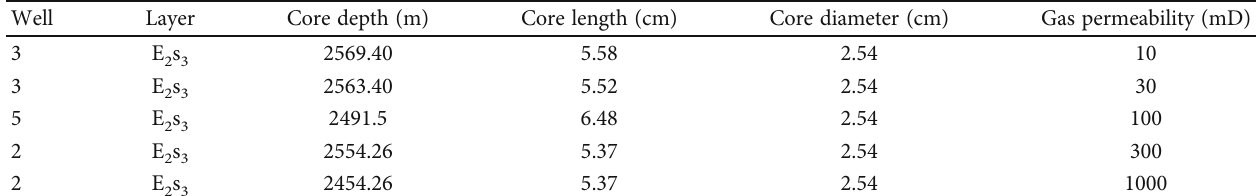
Table 1: Table of core